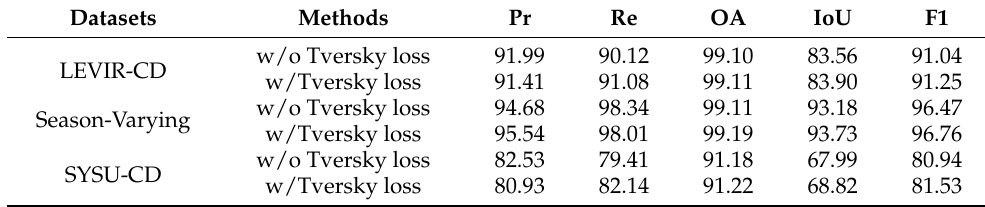
Table 8. Effects of Tversky loss.